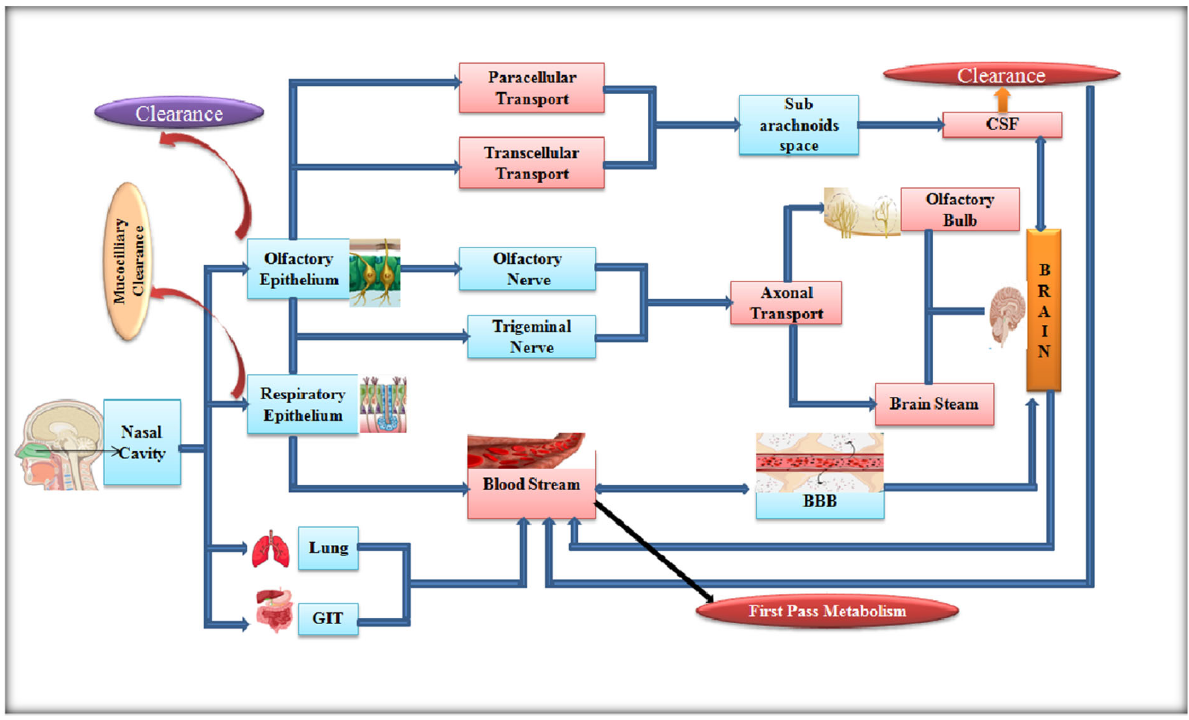
Figure 1. Complex pathway involved in the transport of therapeutics through nose ‐ to ‐